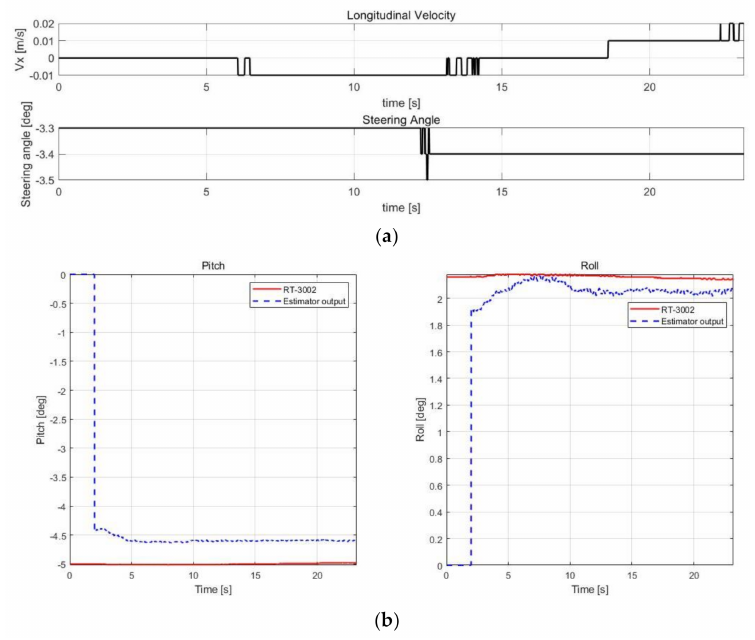
Figure 5. Validation results of Case 1. ( a ) Speed and steering profile. ( b ) Roll/pitch estimation results.